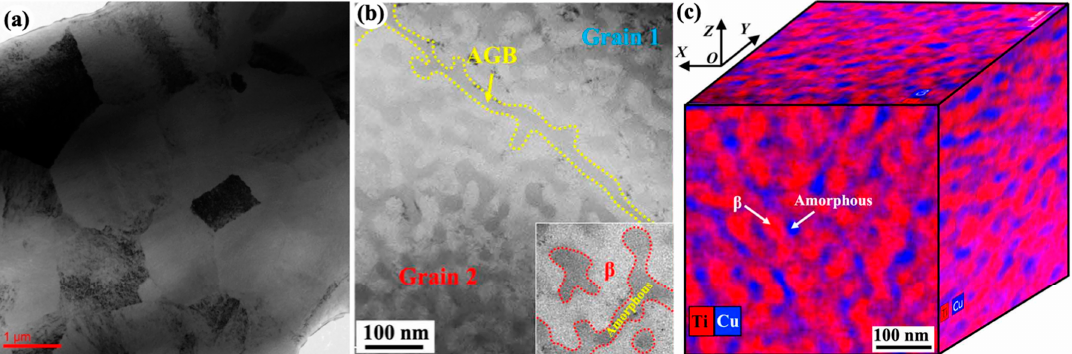
Figure 5. TiZr-based crystalline–amorphous composite [62]: ( a ) A BF-TEM image showing the polycrystalline structure with average grain size of 3 um; ( b ) A TEM image showing amorphous grain boundary, bicontinuous bcc- β (bright) and amorphous (dark) nano-bands; ( c ) A 3D-networked-bicontinuous nanoarchitecture of a grain according to the Ti and Cu distribution maps.